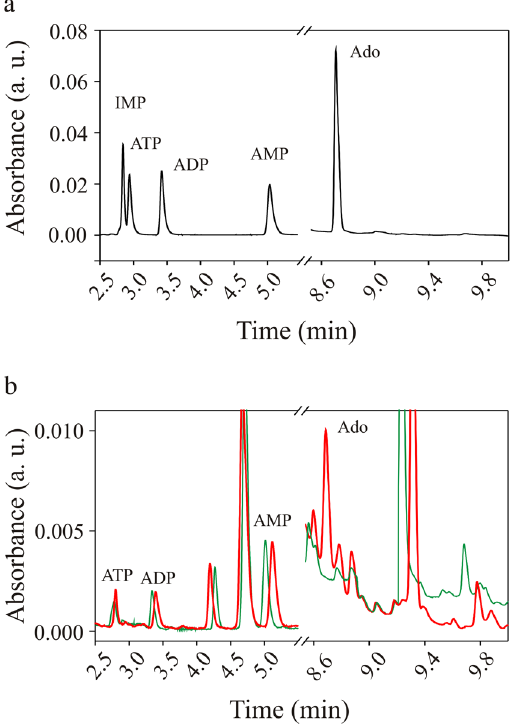
Figure 4. Chromatographic analyses of microglia medium. ( a ) Representative chromatogram of nucleotides standards. ( b ) Chromatogram of samples collected from microglia cultures following treatment in normotonic (green) and hypotonic (red) condition for 5